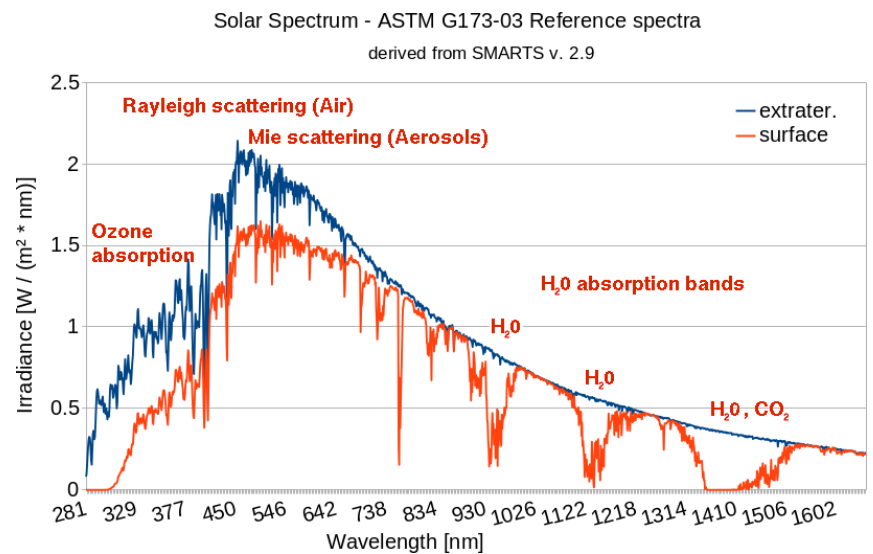
Figure 2. Illustration of the solar irradiance spectrum at the top of atmosphere (extraterrestrial irradiance) and the surface for cloud free skies. The main processes leading to the attenuation of irradiance are shown in the associated spectral